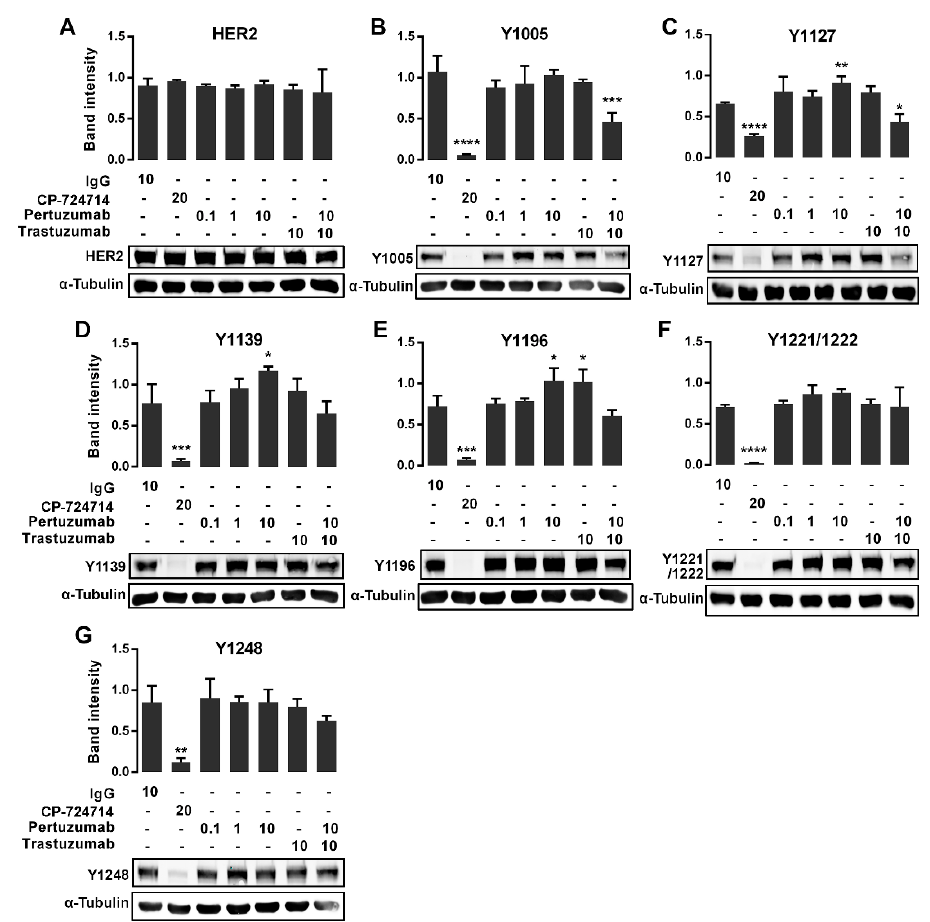
Figure 3. Immunoblot expression of pHER2 in pertuzumab treated CHO-K6 cells. CHO-K6 cells were treated with 0.1, 1 and 10 µ g/mL pertuzumab, 10 µ g/mL trastuzumab and their combination for 60 min. Ten µ g/mL human IgG and 20 µ M CP-724714 were used as mock and positive controls respectively. The expression of ( A ) total HER2, ( B ) pY1005, ( C ) pY1127, ( D ) pY1139, ( E ) pY1196, ( F ) pY1221/1222 and ( G ) pY1248 HER2 was monitored by immunoblotting. * p < 0.05, ** p < 0.01, *** p < 0.001, **** p < 0.0001.